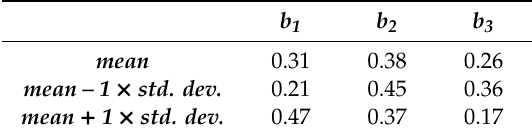
Figure 6. Fitted power-function (Equation (6)) between correlation length and rainfall duration in solid black with confidence limits (mean +/ − std. dev.) in dashed lines. Grey dots indicate values for individual storms, and black circles indicate mean values for each duration. Table 2. Calibrated values of the three parameters of Equation (8) for mean and mean +/ − std. dev.